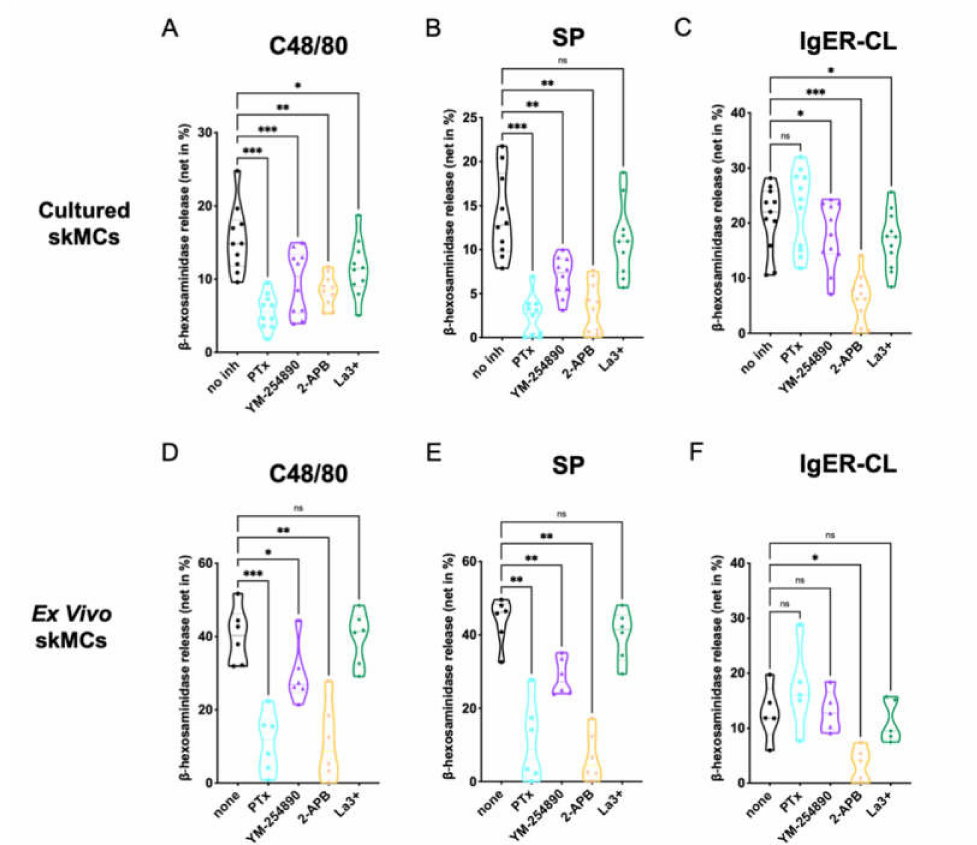
Figure 1. MC degranulation via MRGPRX2 relies on G α i , G α q and calcium mobilization. ( A – C ) Cultured or ( D – F ) ex vivo skin-derived MCs were pretreated with 200 ng/mL PTX, 10 µ M YM-254890, 100 µ M 2-APB or 1 µ M La3+. Then cells were triggered by 10 µ g/mL c48/80, 30 µ M SP or IgER-CL (cross-linking) (0.1 µ g/mL anti-Fc ε RI-antibody AER-37), β -hexosaminidase release was determined as described in methods. Data are from 5–11 independent experiments, ns: not significant, * p < 0.05, ** p < 0.01, *** p < 0.001, skMCs: skin mast